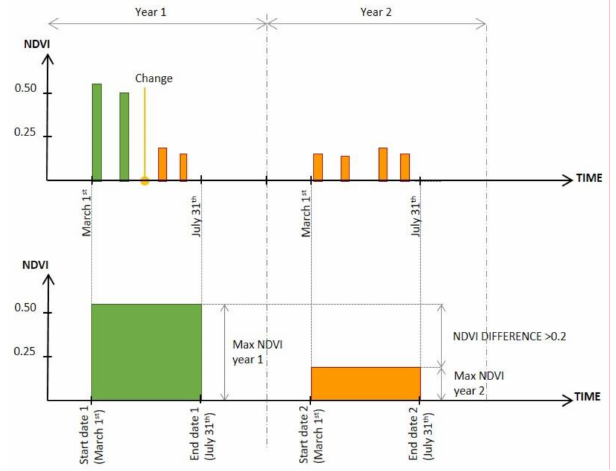
Figure 3. Scheme of change that occurred between start date 1 and start date 2 detected by the methodology; the upper chart represents the NDVI values of a pixel at different acquisition times; the lower chart represents the maximum NDVI value resulting from the acquisition periods of the 2 years.